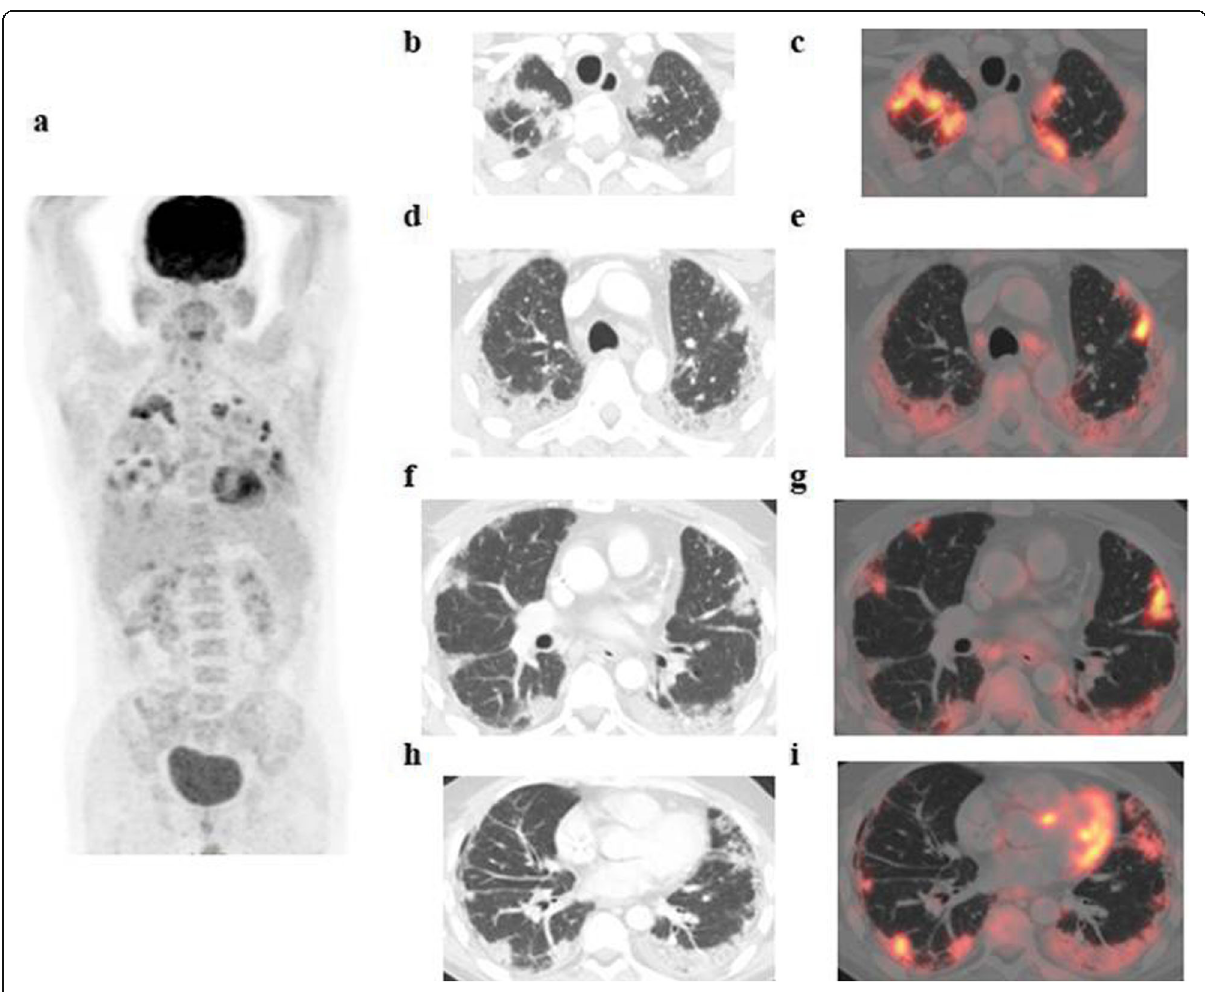
Fig. 6 A 47-year-old male patient, with a history of left testicular seminoma, underwent left orchidectomy and received CTH, referred for follow-up PET/CT examination. The whole-body MIP image ( a ) shows bilateral multiple pulmonary metabolically active areas. Axial lung window CT images ( b , d , f , h ) revealed multiple bilateral subpleural variable-sized consolidations and ground-glass opacities with crazy- paving appearance that show variable FDG avidity on corresponding fused PET/CT images ( c , e , g , i ) achieving up to 10.9 SUV